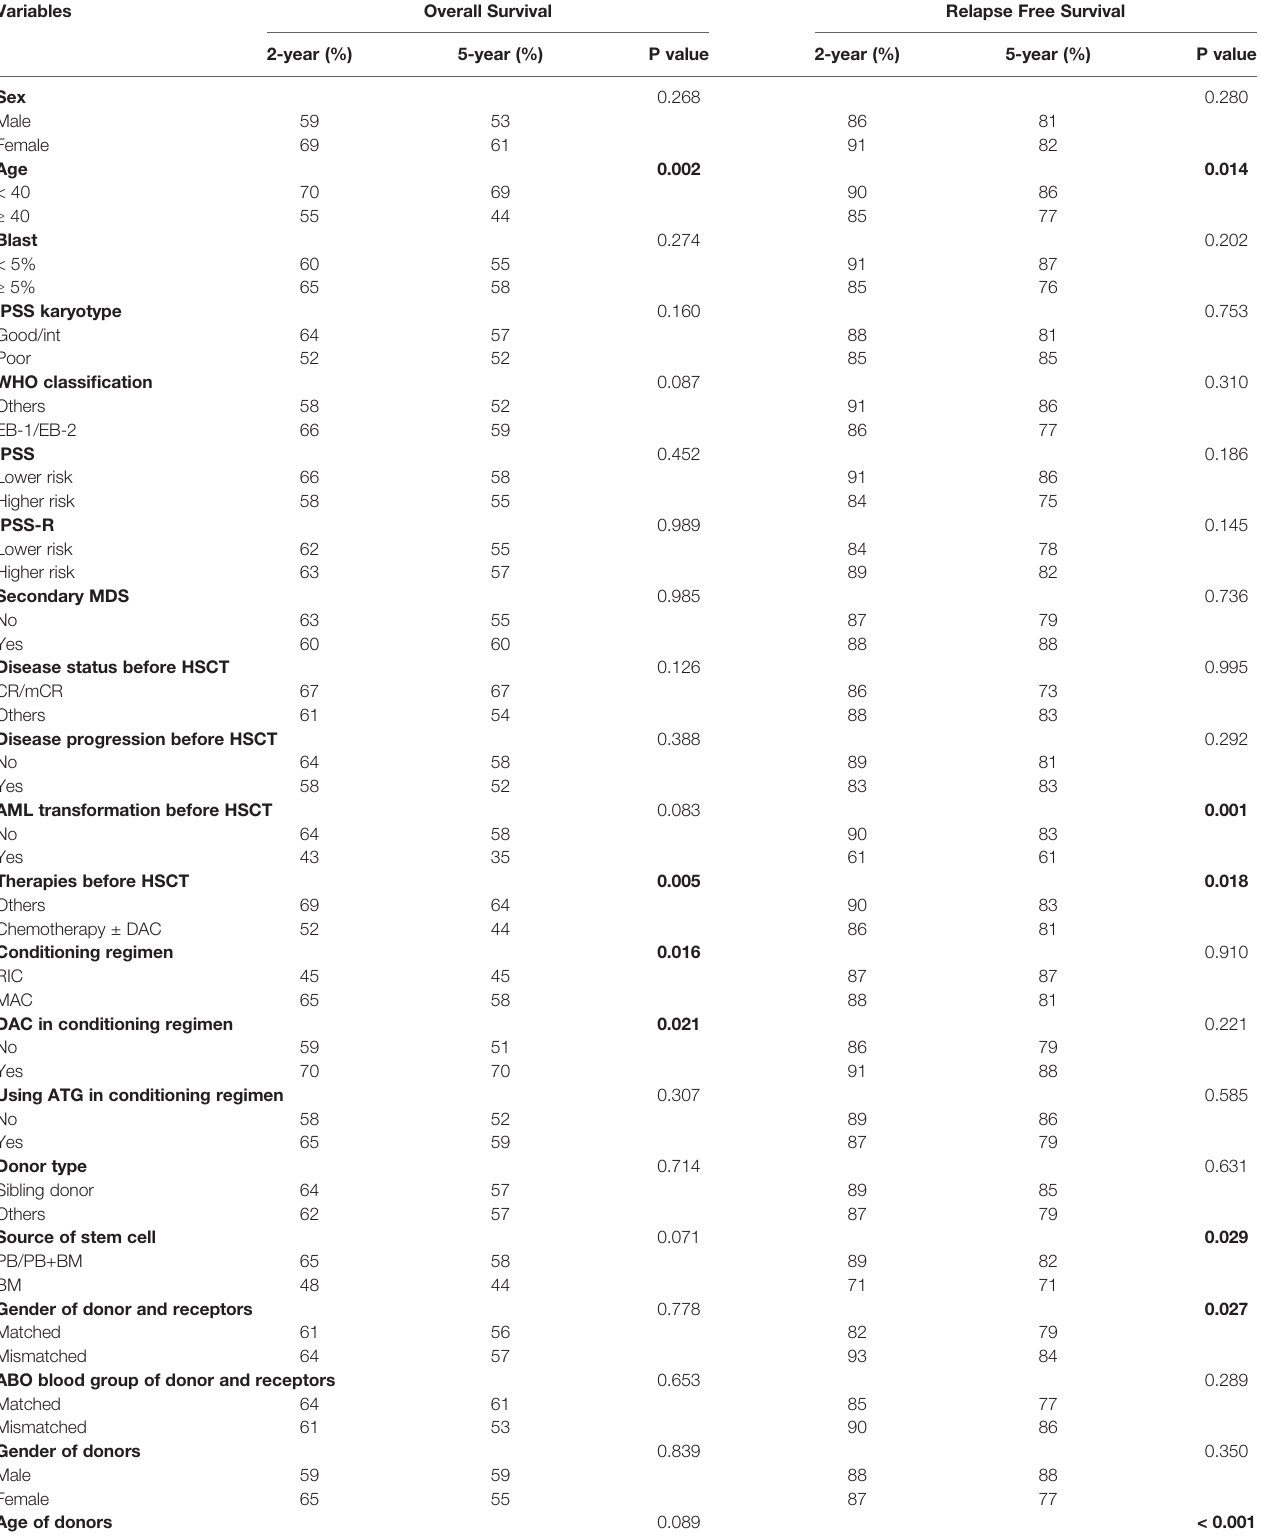
TABLE 2 | Univariate analysis of OS and RFS in MDS patients who received HSCT.